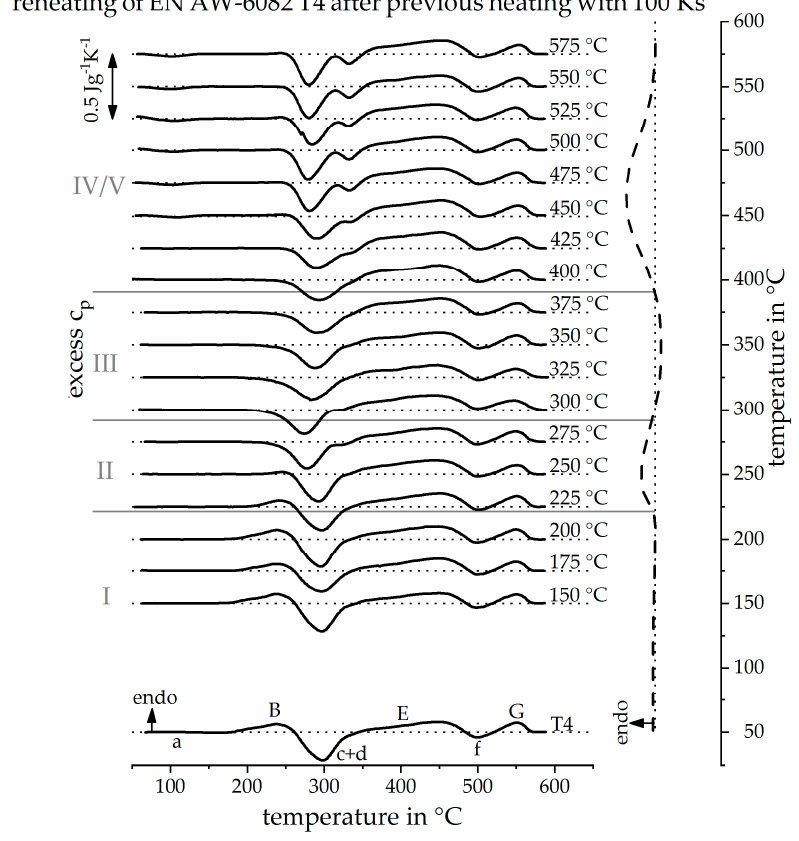
Figure 11. Reheating curves after a heat treatment with a heating rate of 100 Ks − 1 up to different maximum temperatures and the resulting reconstructed heating curve at 100 Ks − 1 .